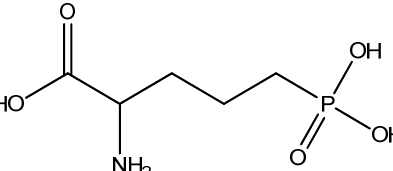
Figure 22. APV (D-AP5).